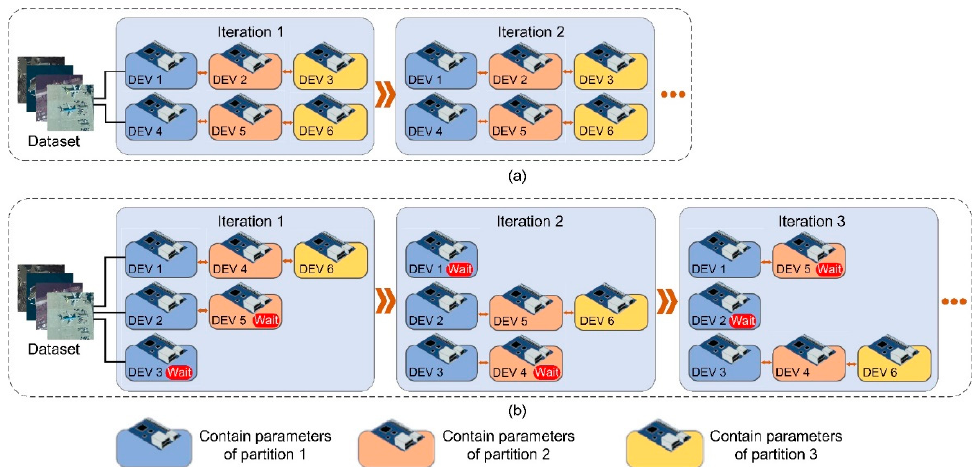
Figure 4. Illustration of our proposed distributed hybrid parallel training baseline and dynamic chain system. ( a ) Distributed hybrid parallel training baseline. ( b ) Dynamic chain system. In iteration 1, Devices 1, 4, and 6 forms a computation chain, while Devices 3 and 5 are in a waiting state. During this time, Device 5 completes the forward computation from Device 2. At the end of iteration 1, Device 6 disconnects from Device 4, automatically links to Device 5, and immediately performs the third part of the training, Device 4 links to Device 3 and waits to link with Device 6. In iteration 3, Device 4 links to Device 6, and the rest nodes also link to available nodes. Subsequent iterations follow the same procedure.